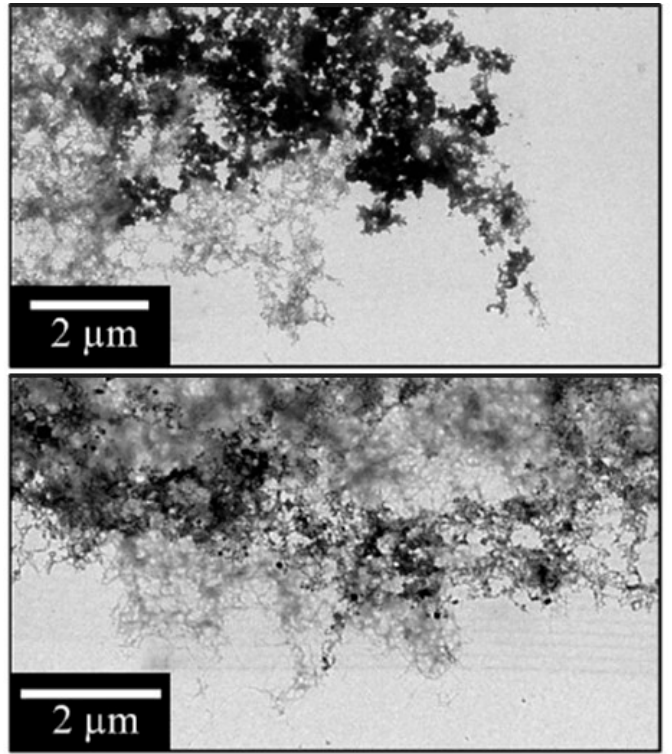
Figure A6. Additional high magnification TEM images from the aggregate shown in Figure 3.